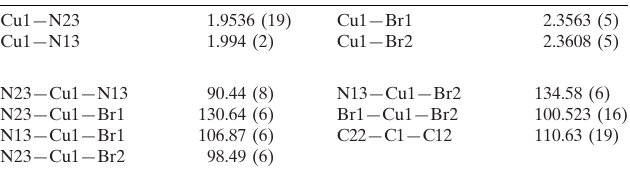
Hydrogen-bond geometry (A˚ , (cid:3) ).